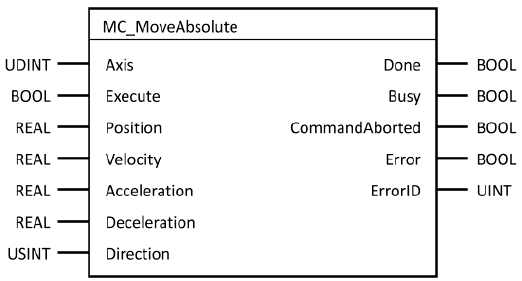
Figure 2. PLCopen Motion Control MC_MoveAbsolute()function block.